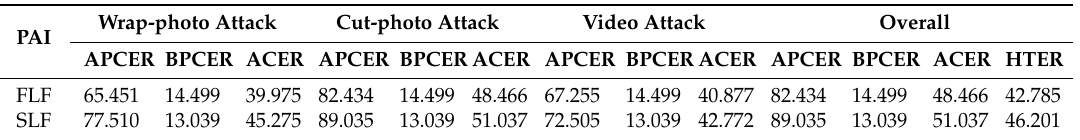
Table 12. Detection results (APCER, BPCER, ACER, and HTER) of cross-dataset testing (Trained with Replay-mobile; Tested with CASIA) (unit: